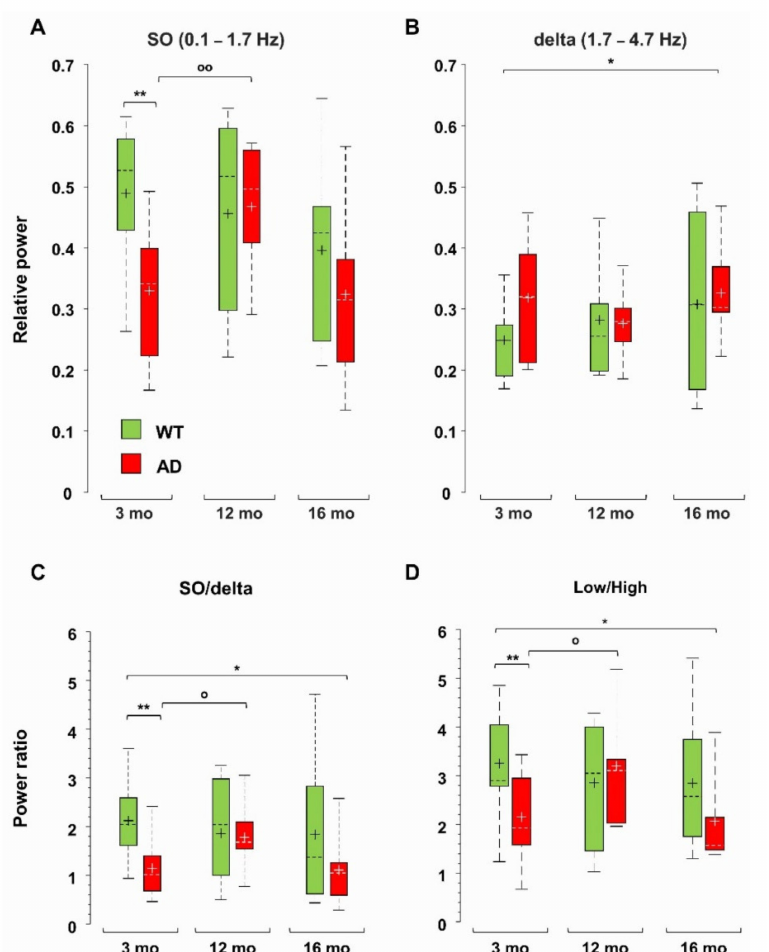
Figure 3. Loss of hippocampal SO relative power and power imbalances characterize young AD mice. Boxplots of the relative power of SO (0.1–1.7 Hz) ( A ) and delta (1.7–4.7 Hz) waves ( B ) in CA1 ( sr-lm , 1500 µ m) of WT and AD mice. At each frequency band, the relative power is the percentage of the total power at the specific depth. Boxplots of the power ratios between SO and delta waves ( C ), and between Low (0.1–4.7 Hz) and High (4.7–190 Hz) frequency bands ( D ), * p < 0.05; ** p < 0.01). In 12-month-old AD mice, there is a significant increase in SO ( A ) and SO/delta ratio ( C ) versus 3-month-old AD mice, o p < 0.05; oo p <